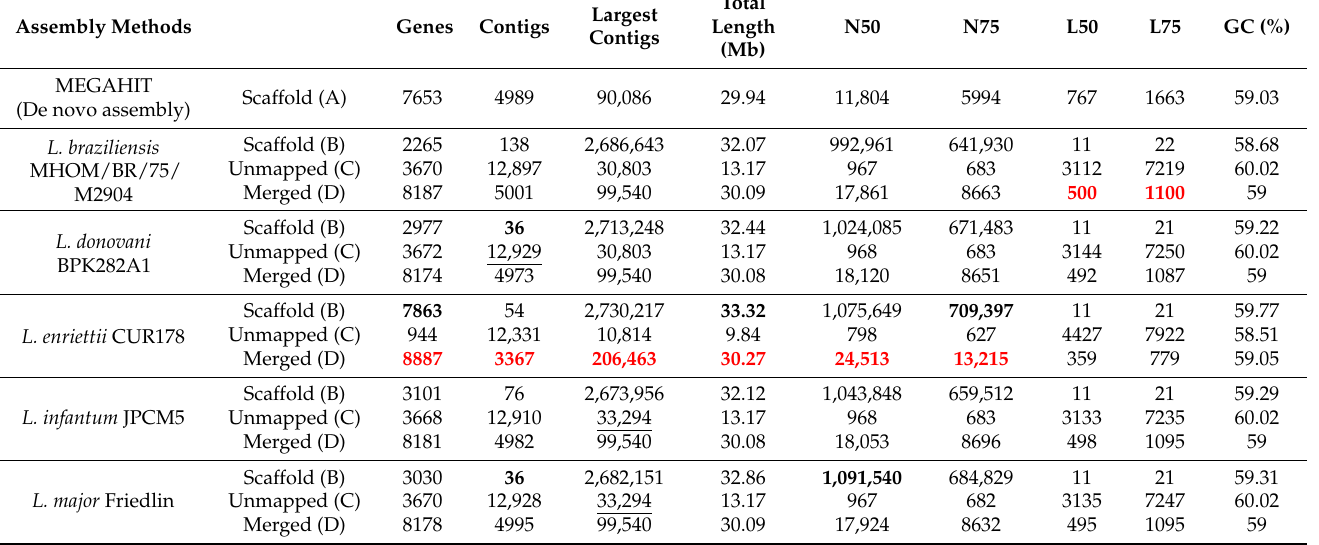
Table 2. Comparative assembly parameters of L. orientalis isolate PCM2 obtained from different assembling strategies: a single de novo step (A), the reference-based assembly alone with six reference genomes of Leishmania (B), the de novo assembly of the unmapped reads (C), and the multi-step de novo assembly and referenced-based method (D), compared with the reference genome of another L. orientalis isolate LSCM4. Bold numbers represent the maximum numbers for the (B) method. Underlined numbers represent the maximum numbers for the (C) method. Red numbers represent the maximum numbers for the (D)